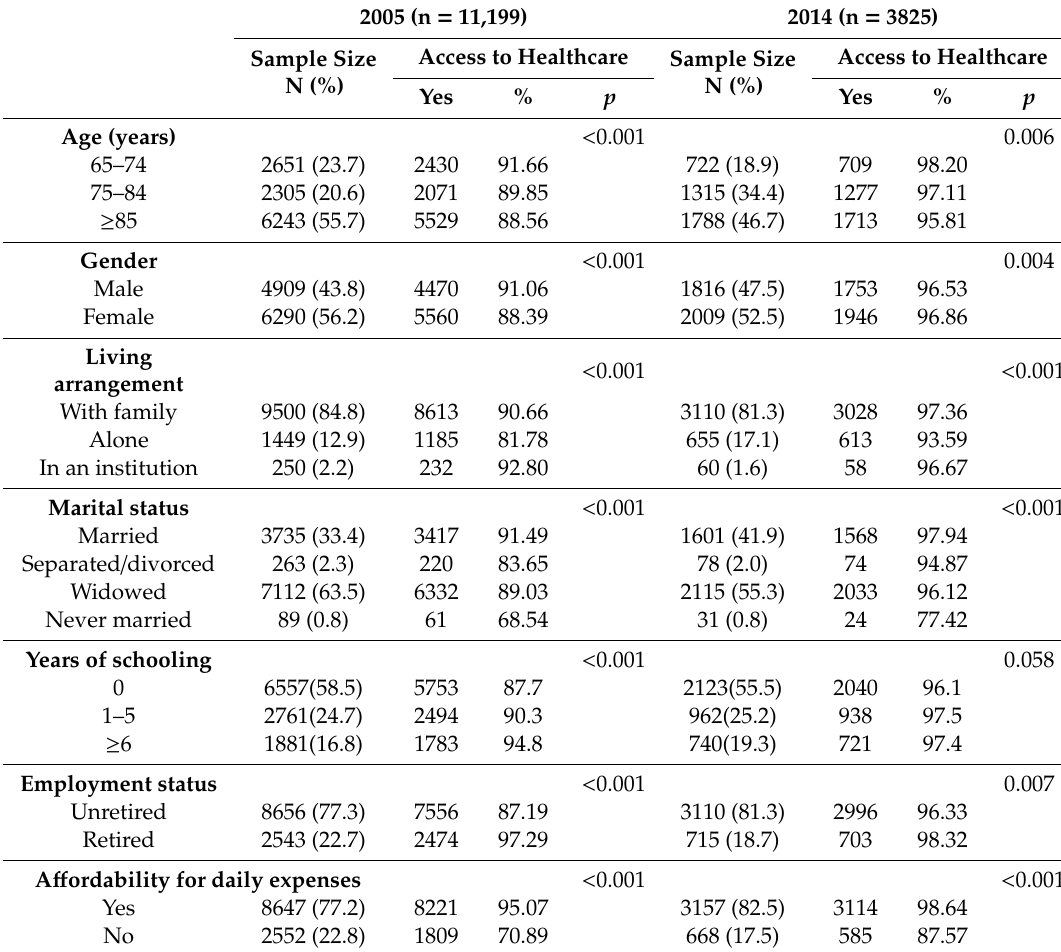
Table 1. Perceived accessibility to healthcare in 2005 and 2014 stratified by the explanatory